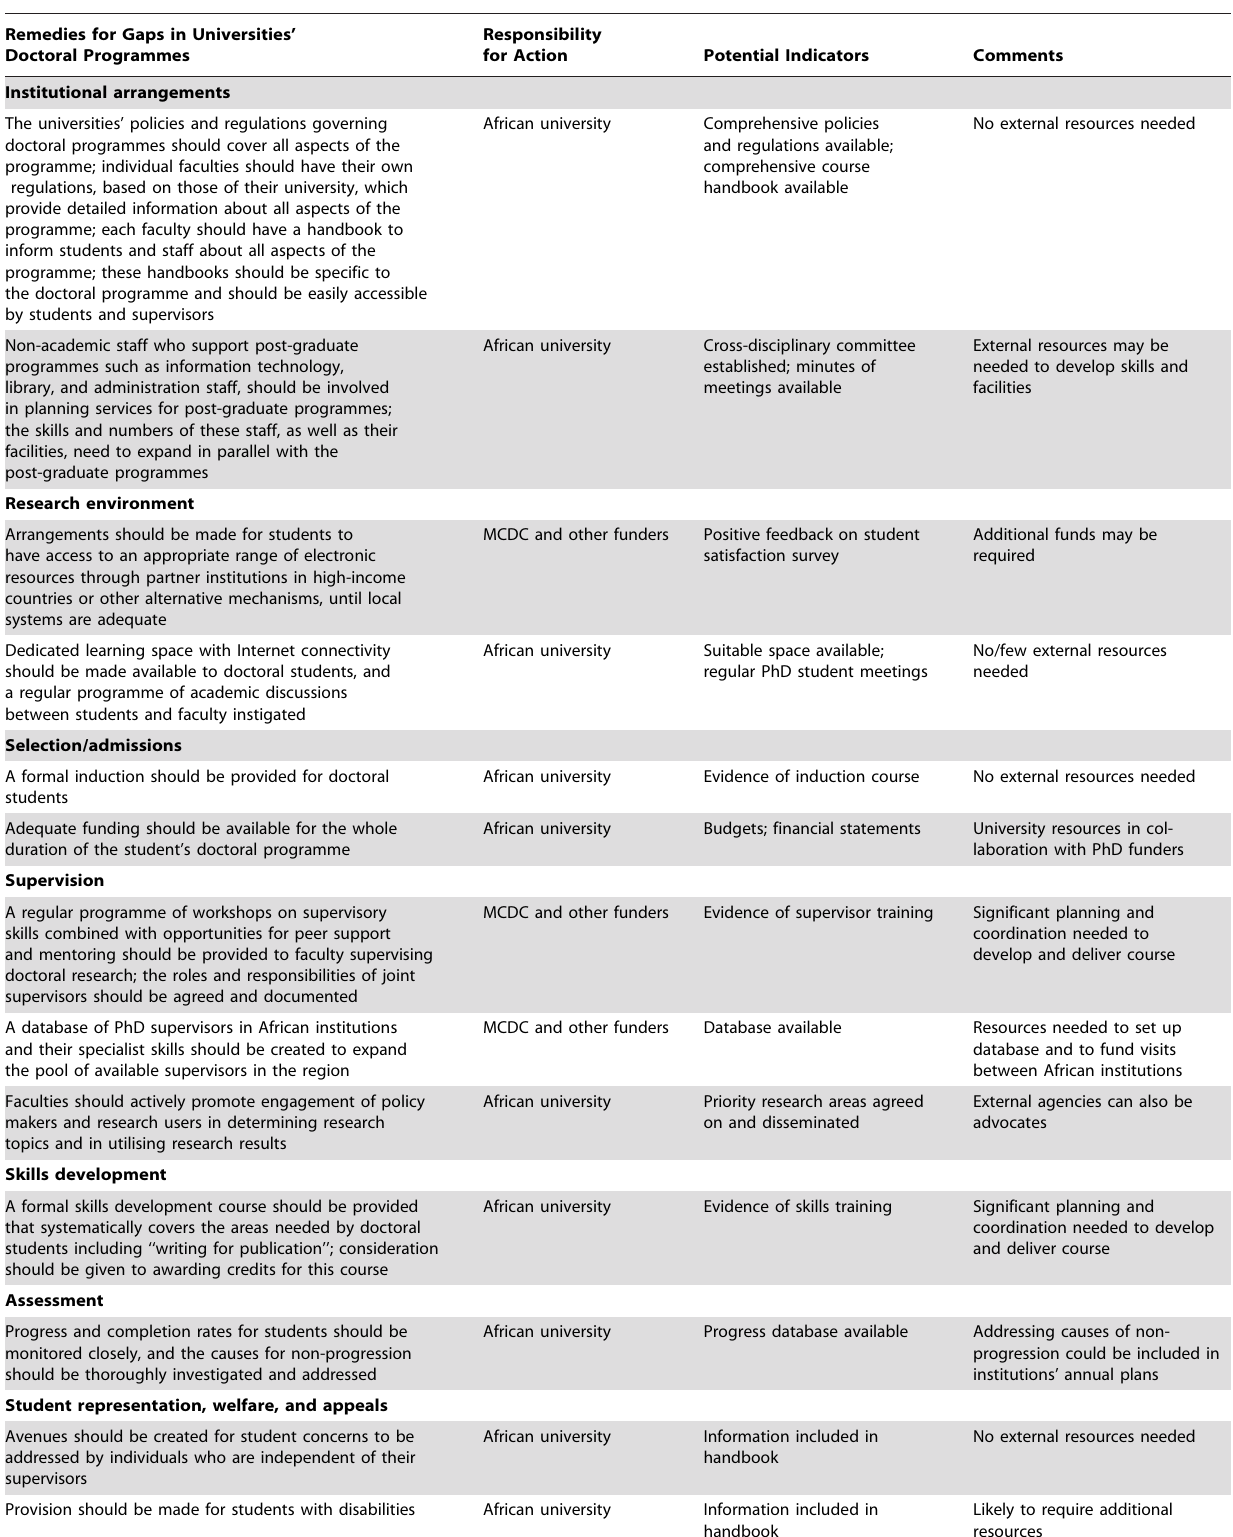
Table 1. Potential remedies for gaps that occurred commonly in five African universities’ capacity for managing doctoral